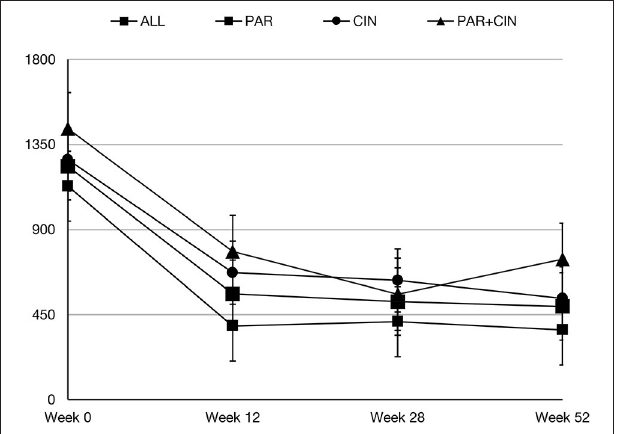
FIGURE 1 | Serum iPTH concentration during observation period.